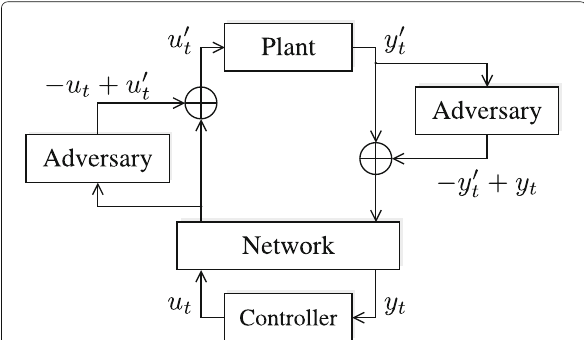
Fig. 1 Sample representation of a cyber-physical attack against a networked-control